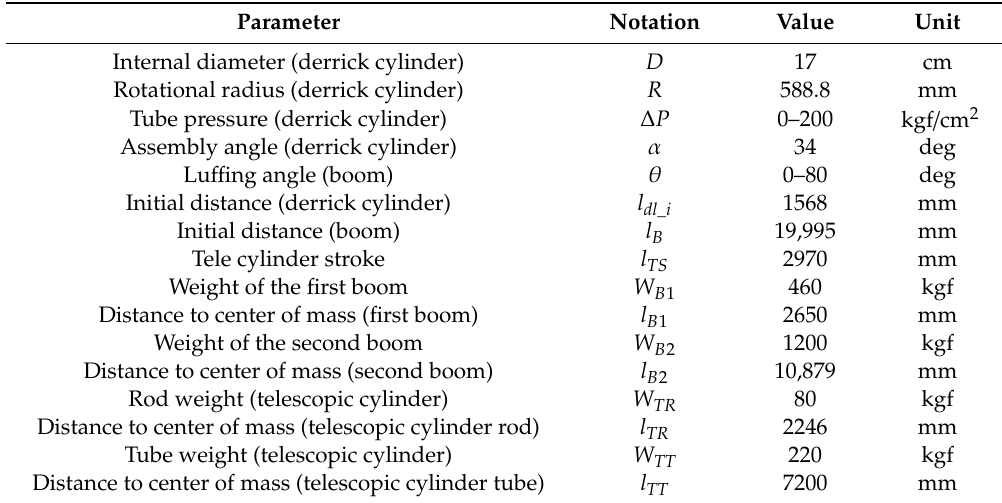
Table 2. Midsize cargo crane (7.5 ton) parameters.